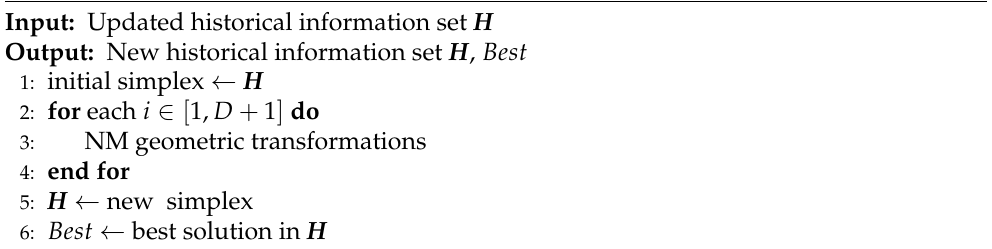
Algorithm 3 Utilize historical information based on NM geometric transformations